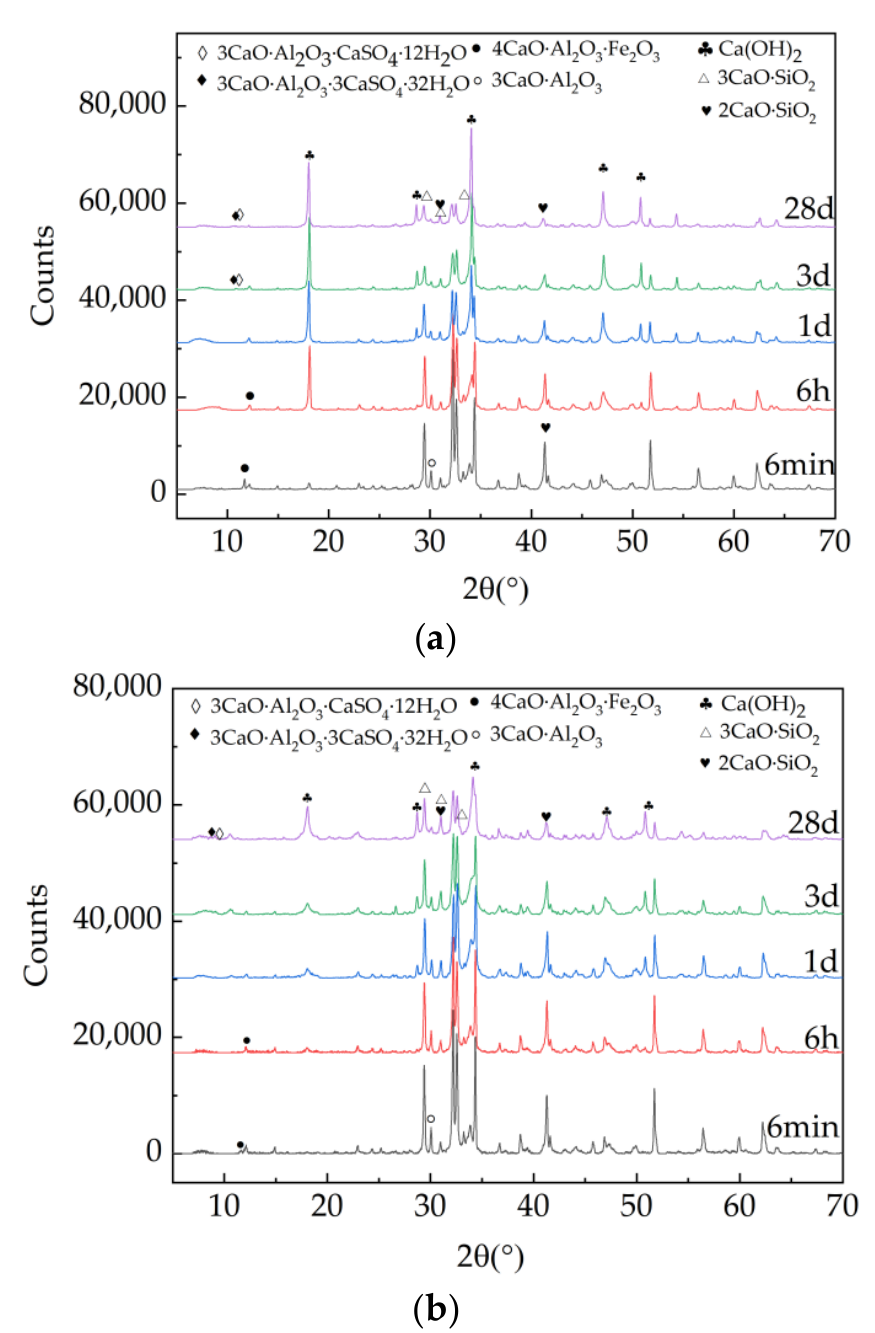
Figure 10. X-ray diffraction patterns of specimens. ( a ) X-ray diffraction pattern of blank group, ( b ) X-ray diffraction pattern of the sample with 7% accelerator.